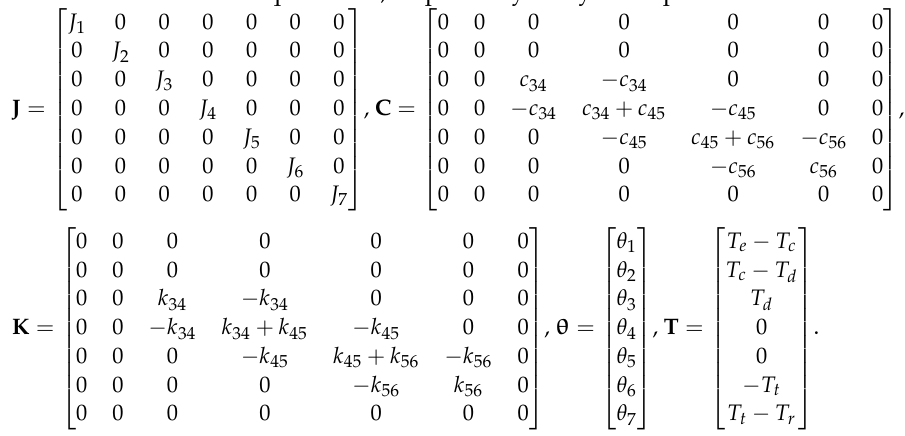
where 𝑟 is the crank radius, 𝑙 is the connecting rod length, 𝜆 = 𝑟 / 𝑙 is a scale factor, 𝛼 is the crankshaft angle and 𝛽 is the intersection angle between connecting rod and cylin- der longitudinal axis. Considering the McLaughlin expansion, the velocity 𝑥(cid:4662) (cid:3043) and accel- eration 𝑥(cid:4663) (cid:3043) of piston can be expressed as: